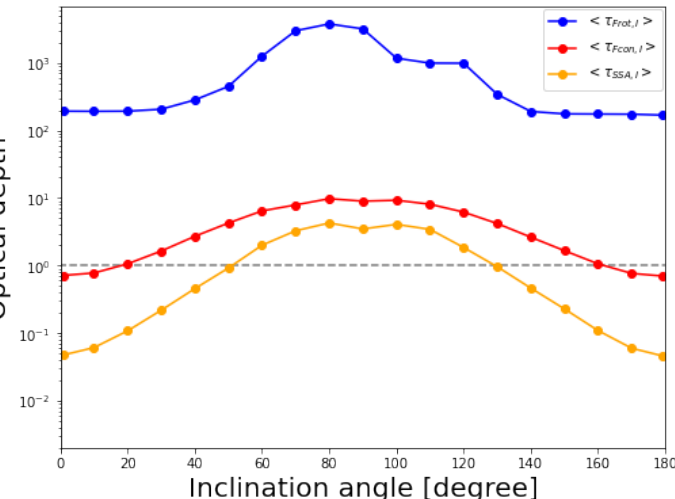
Figure 5. Diagram of the image-integrated intensity-weighted optical depths for Faraday rotation and conversion, and SSA at 230 GHz for different inclination angles. Gray dashed line corresponds to τ =